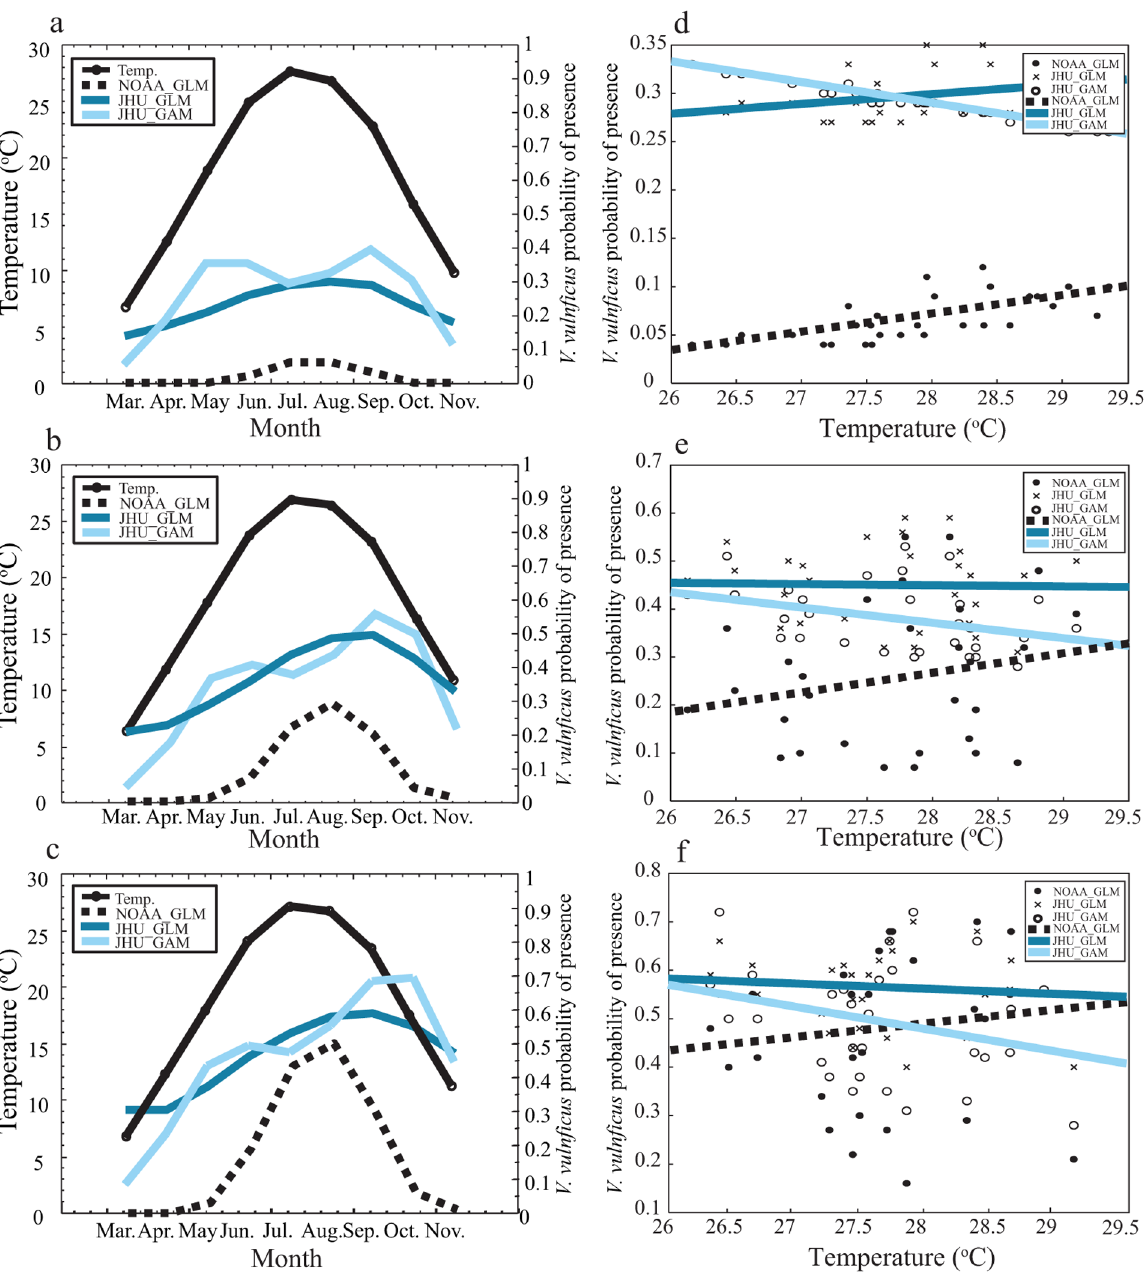
Figure 3. Monthly climatology of temperature and V.vulnificus probability for each method in the upper (a), mid (b), and lower (c) regions of the Chesapeake Bay. Peak temperature observations by year versus V. vulnificus probability for each method in the upper (d), mid (e), and lower (f) regions of the Chesapeake Bay. Trend lines are included for each method’s observations.